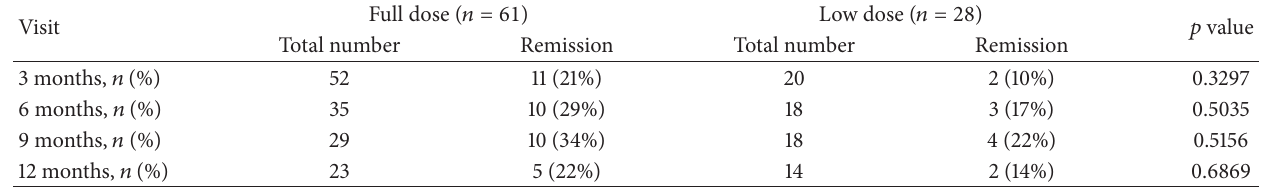
Table 3: Between-group comparison of patients who achieved clinical remission.